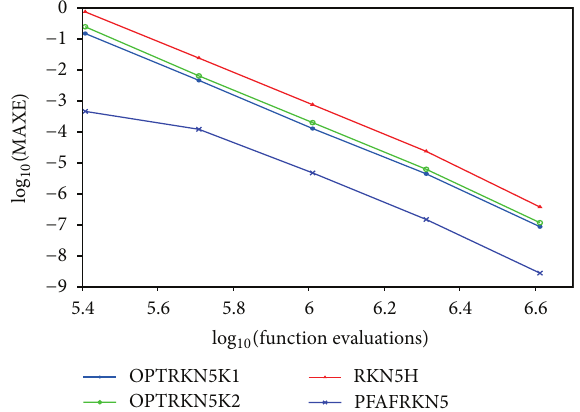
Figure 7: Efficiency curves for all methods for Problem 4 with ℎ = 1/2 𝑖 , 𝑖 = 1, ...,5 .